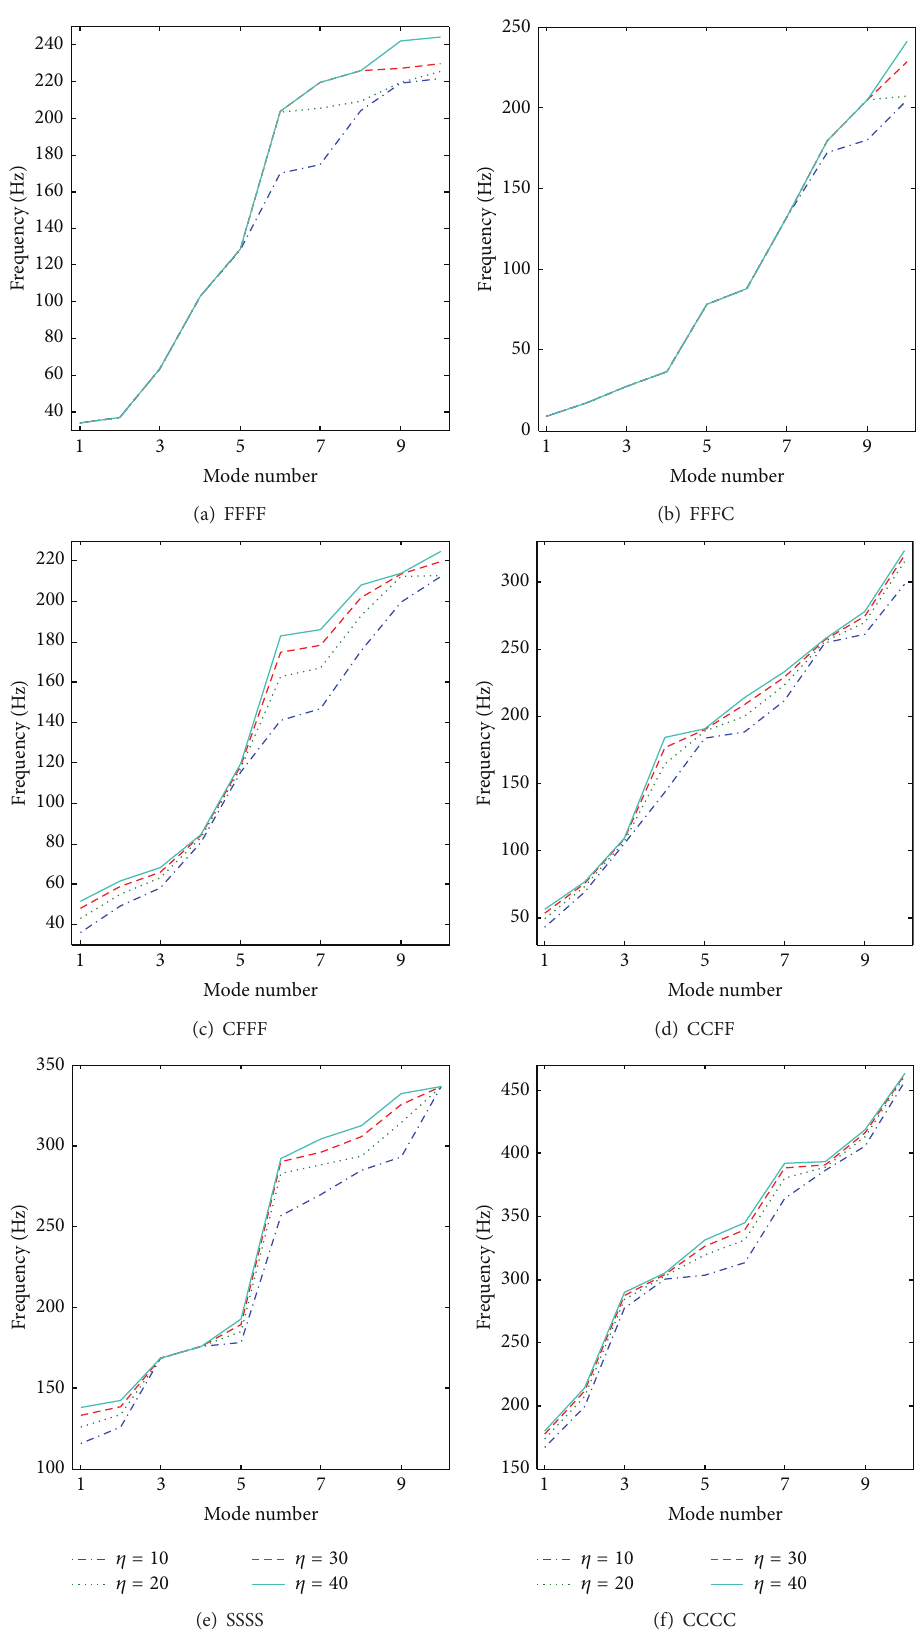
Figure 6: Variation of the first ten frequencies (Hz) against material parameter 𝜂 ( 𝜂 = 𝐸 11 /𝐸 22 ) for an open cylindrical shell with different boundary